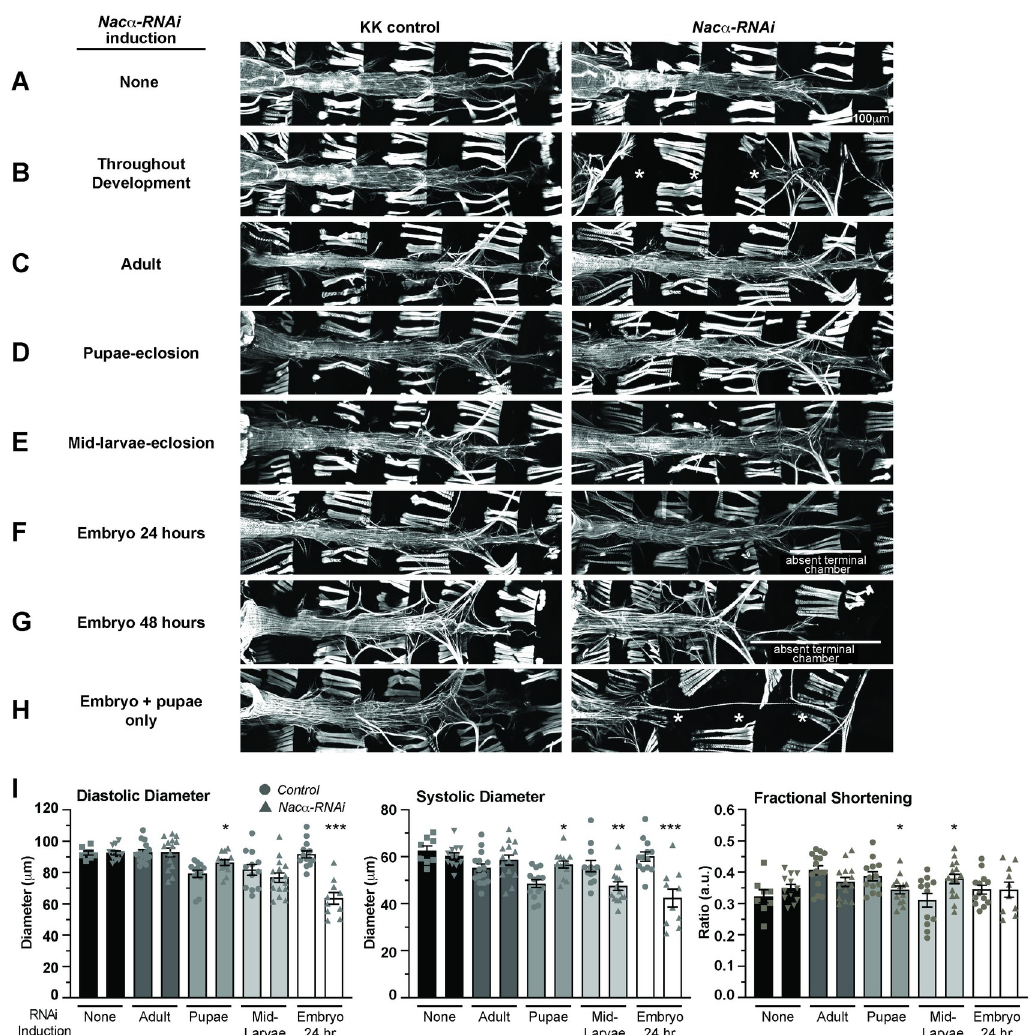
Fig 4. Temporal regulation of Nac α - RNAi expression in the heart. Using a temperature inducible driver specifically in the heart (HTT, Hand4 . 2 -GAL4, tubulin -GAL80 ts ; tubulin -GAL80 ts ), Nac α - RNAi was expressed during specific stages of development by controlling ambient temperature to determine its contribution to cardiogenesis. Controls lacking RNAi are kept in similar temperature conditions to account for any developmental effects of temperature on the heart. A-H. Phalloidin staining to visualize cytoskeletal structural effects of Nac α knockdown (KD). A, As a test of GAL80 control of transcription, flies held at 18˚C throughout development did not produce changes to heart structure indicating an inhibition of Nac α -RNAi transcription. B, Exposing flies to high temperatures (28˚C) throughout development produced a no heart phenotype similar to the effects of driving Nac α -RNAi using Hand4 . 2 -GAL4 alone, suggesting an induction of Nac α -RNAi transcription and subsequent Nac α KD with exposure to higher temperatures. � indicates absence of the heart. C, Exposing flies to high temperature during adulthood only for 1 week, D, pupae to eclosion, or E, mid-larvae to eclosion did not produce gross structural defects in the heart. F, Exposing embryos to high temperatures starting at egg-lay up until 24 hours resulted in the absence of the terminal chamber, indicated by white bar. Only thin alary muscles were present. G, Extending the high temperature exposure to 48 hours led to similar loss of the posterior heart, indicated by white bar. H, Only when the hearts were exposed to higher temperatures during embryonic stage (24 hours) and pupal stage until eclosion (~3 days), were we able to recapitulate the no heart phenotype produced by exposing the heart to constant high temperatures. I, Functional analysis of the adult heart following Nac α KD at various developmental stages. Maintaining flies at 18˚C throughout development or exposure of adult flies to high temperature for 1 week led to no changes in diastolic diameter, systolic diameter, or fractional shortening. High temperature exposure from pupae to eclosion or from mid-larvae to eclosion led to subtle changes in diameters and fractional shortening. Exposure of embryos to high temperatures for 24hr led to constricted diastolic and systolic diameters. � p < 0 . 05 , �� p < 0 . 01 , ��� p < 0 . 001 .